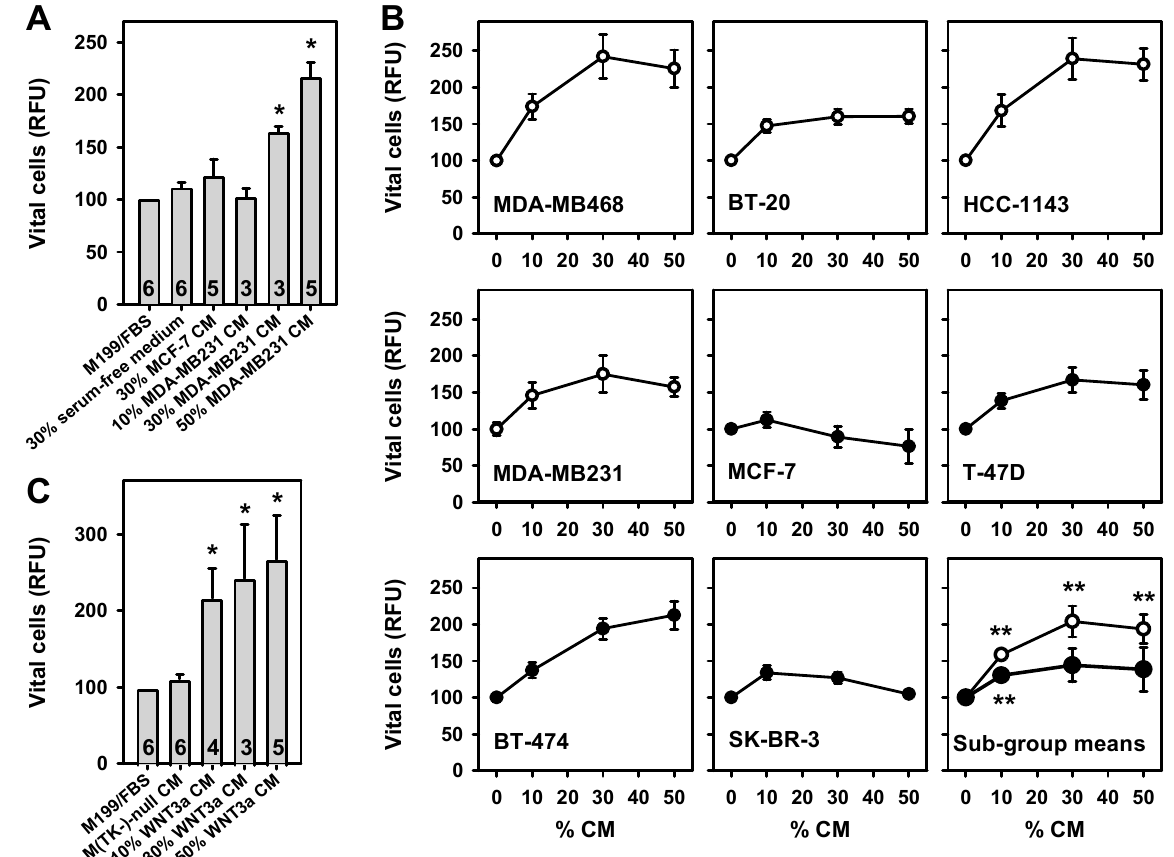
Figure 1. Breast cancer cell line conditioned medium (CM) and WNT3a CM potentiate breast adipose fibroblast (BAF) proliferation. Starting two days after seeding, BAFs were incubated for 8 days with various concentrations of CM. Media were changed every other day. Vital cells were assayed with the fluorescein diacetate (FDA) assay. ( A ) BAFs were cultured in M199 medium, without or with different volume percentages of serum-free CM from MDA-MB231 cells, MCF-7 cells, or with 30% serum-free media alone. MCF-7 CM caused no significant changes in vital cells (parameter for vital cells: RFU, relative fluorescence units). MDA-MB231 CM induced a dose-dependent increase in vital cells. Numbers indicate biological replicates tested in triplicate. ( B ) BAFs were grown in the presence of 50% M199/FBS and various concentrations of serum-free CM from the indicated cell lines (the balance was filled with serum-free medium). n = 2 experiments tested in quadruplicate. Subgroup mean values were calculated from the mean values obtained for the triple-negative and receptor-positive cell lines, respectively. ( C ) WNT3a CM induced a concentration-dependent increase in vital cells, whereas 30% serum-free CM from L-M(TK-)-null cells, not expressing WNT3a, had no such effect. All values represent means ± SEM, and were normalized to 100% M199/fetal bovine serum (FBS) (*, p < 0.05; **, p < 0.005; versus M199/FBS or 0% CM, respectively).